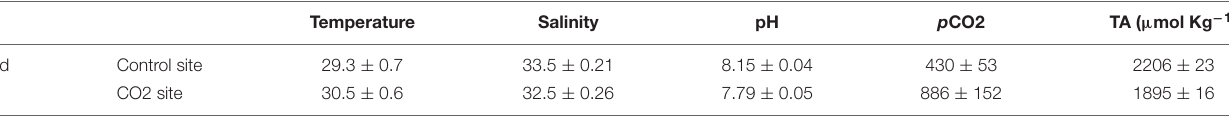
FIGURE 5 | Lipid percentage in Pocillopora acuta larvae released from adults collected at control (white bar) and high-CO 2 site (black bar) sites at Day 0, and at Day 5 after being reciprocally reared under control or high CO 2 conditions. At Day 0, differences among larvae from control and high-CO 2 sites were compared by t -test. After 5 days of culture, the lipid concentration display an interaction effect among the origin of adult and the condition of seawater the larvae were cultured under [ F ( 1 , 17 ) = 7.74, p = 0.01]. Different letters show significant differences among treatment by Tukey’s HSD. The replicate number are shown as n in the graph. Average ± SD. TABLE 2 | Seawater carbon chemistry measured at control and CO 2 site at field where the adult corals were reciprocally transplanted for 7 months. Temperature